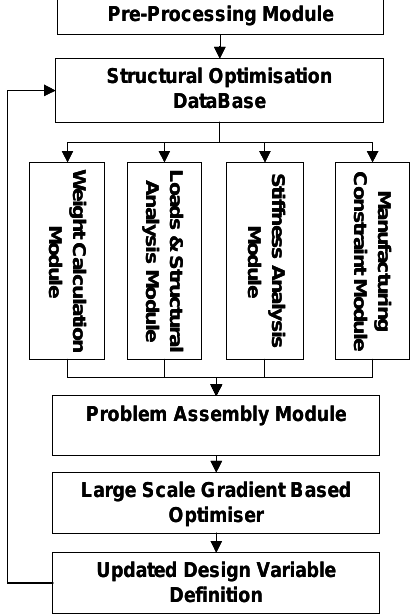
Fig. 25: Top level modular architecture and